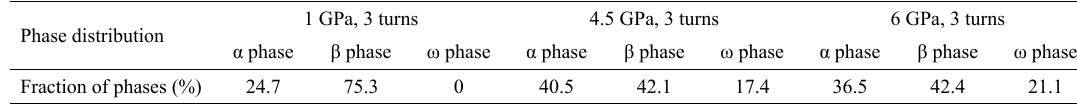
Table 3. Phase distribution in samples deformed by HPT.